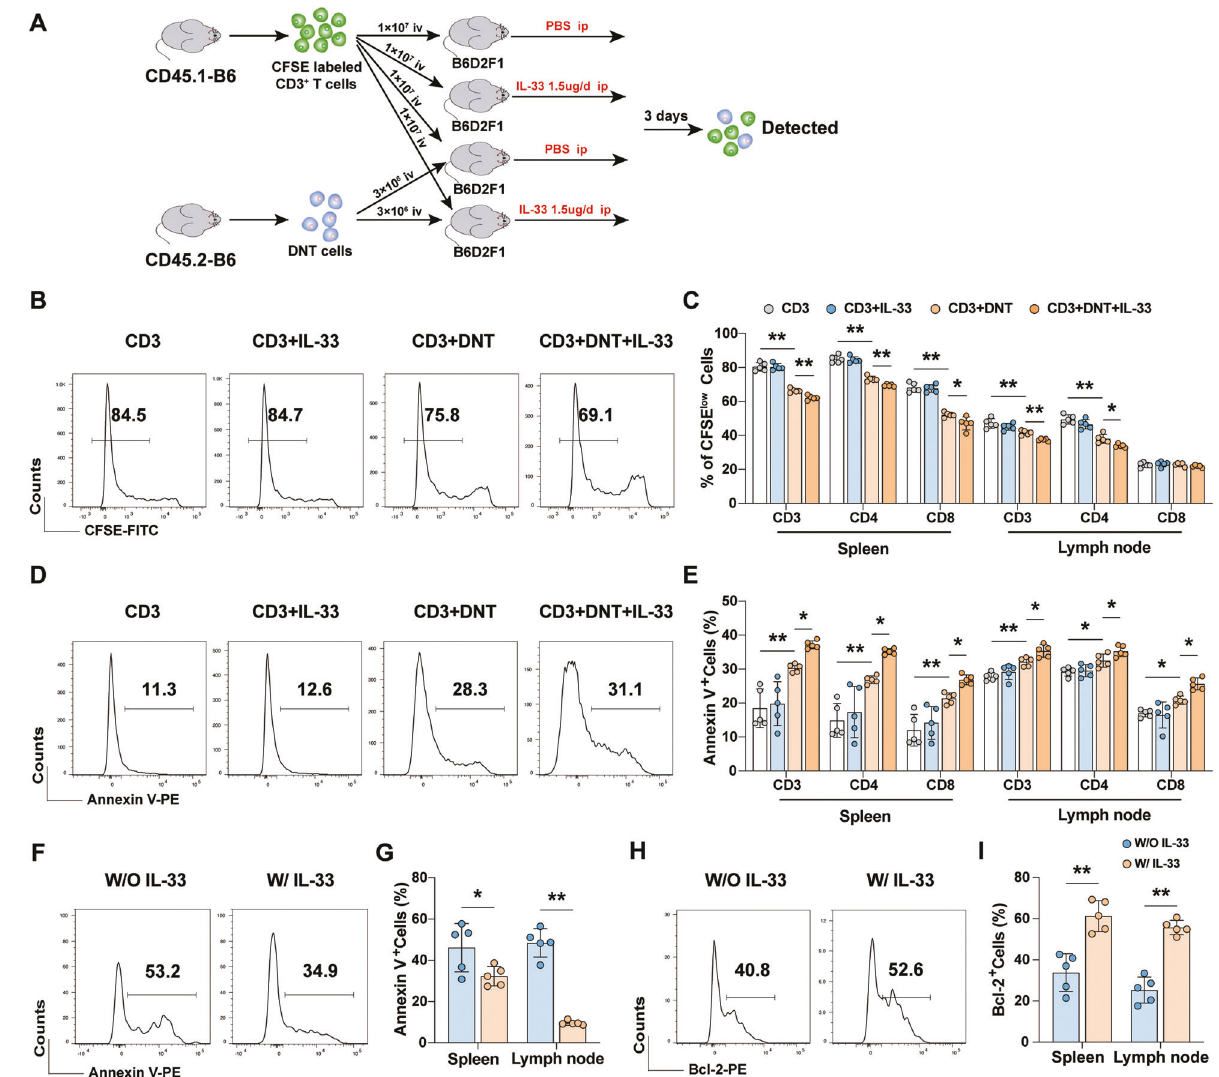
Fig. 5 IL-33 enhanced DNT cell function by promoting its expansion. A Flowchart showing suppression test method in vivo. B Representative fl ow cytometric results showing the proliferation of adoptively transferred CD4 + T cells, as examined by CFSE in the spleen. C Statistical analysis of the percentage of proliferating CD3 + T cells, CD4 + T cells and CD8 + T cells in spleen and lymph nodes in each group. Representative fl ow cytometric results of apoptosis in adoptively transferred CD4 + T ( D ) and DNT cells ( F ) in the spleen. E , G Statistical analysis of the apoptosis rates in the spleen and lymph nodes in each group. H Representative fl ow cytometric results of Bcl-2 expression in adoptively transferred DNT cells in the spleen. I Quanti fi cation of Bcl-2 expression levels in spleen and lymph nodes in each group. Data in C and E